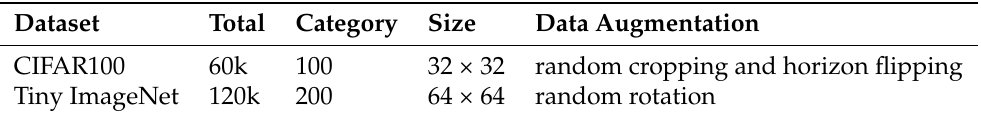
Table 1. The details of the